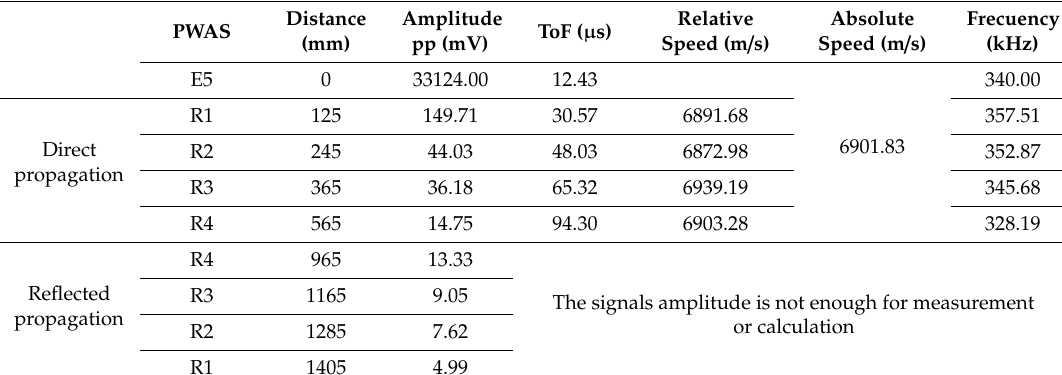
Table 1. Magnitudes measured in the PWAS and calculated during the basic UGWT.